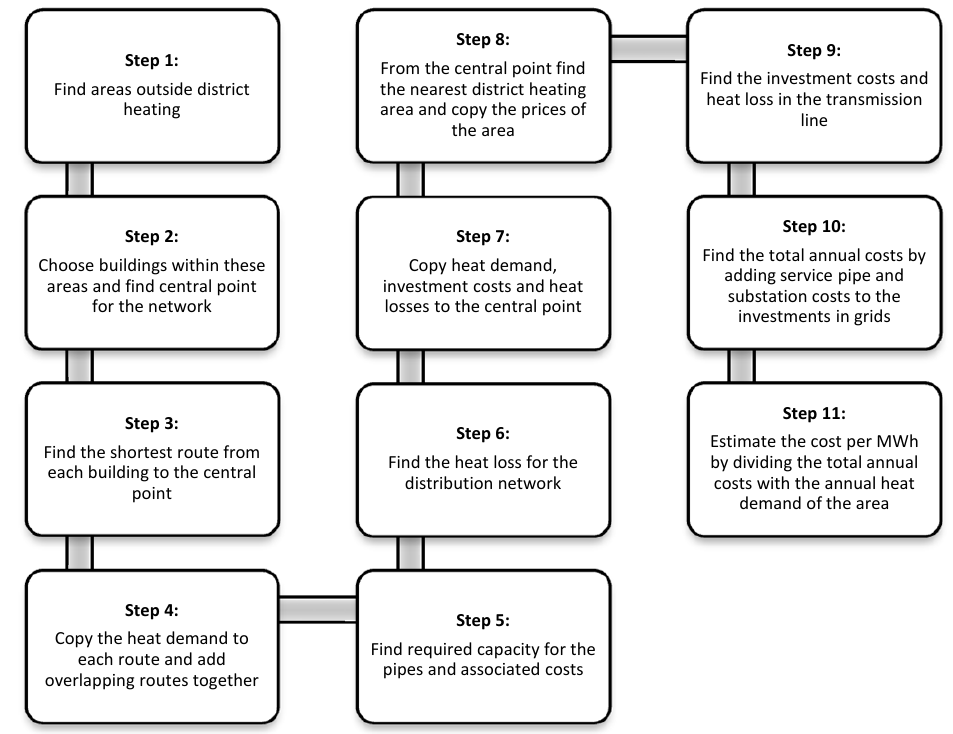
Figure 5. The generalised approach in the GIS (Geographical Information System) model. Table 3. Capacities of different pipe